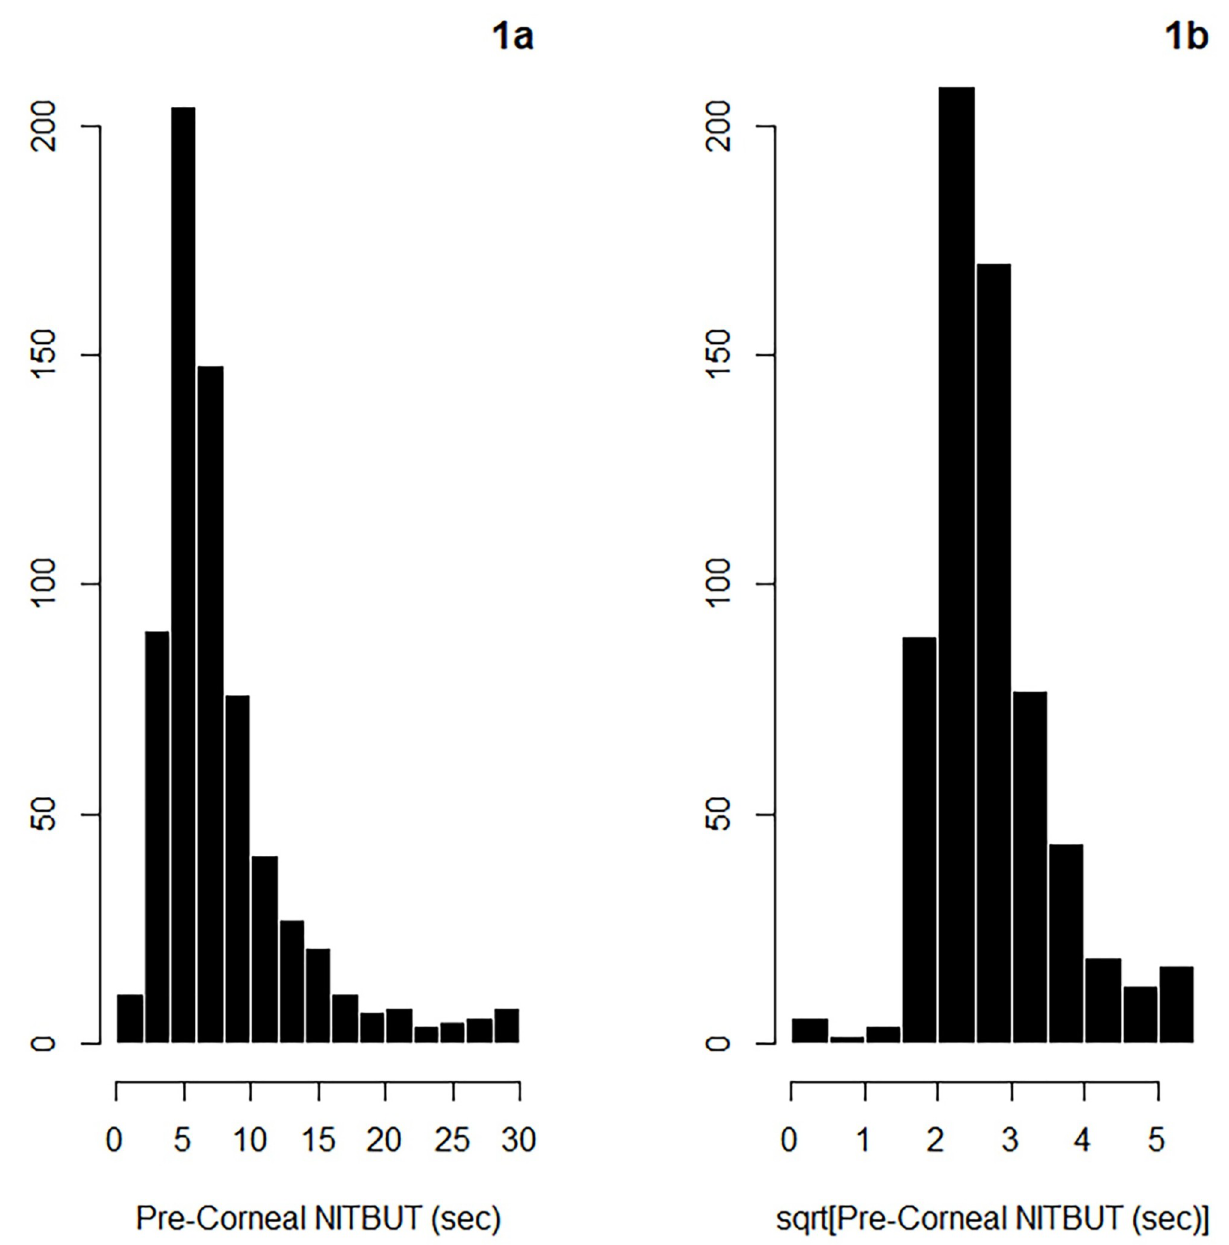
Fig 1. Distributions of raw (1a) and square root-transformed (1b) pre-corneal NITBUT (all data combined, n = 667). Baseline pre-corneal NITBUT ranged from 0 to the maximum value of 30 sec, with a median of 6.67 sec, and a mean (SD) of 8.48 (5.96) sec. The distribution of baseline pre-corneal NITBUT is depicted in Fig 1a. It is evident from the figure that the distribution of raw NIT- BUT was right-skewed, therefore we elected to analyze the square root-transformed NITBUT, depicted in Fig 1b.